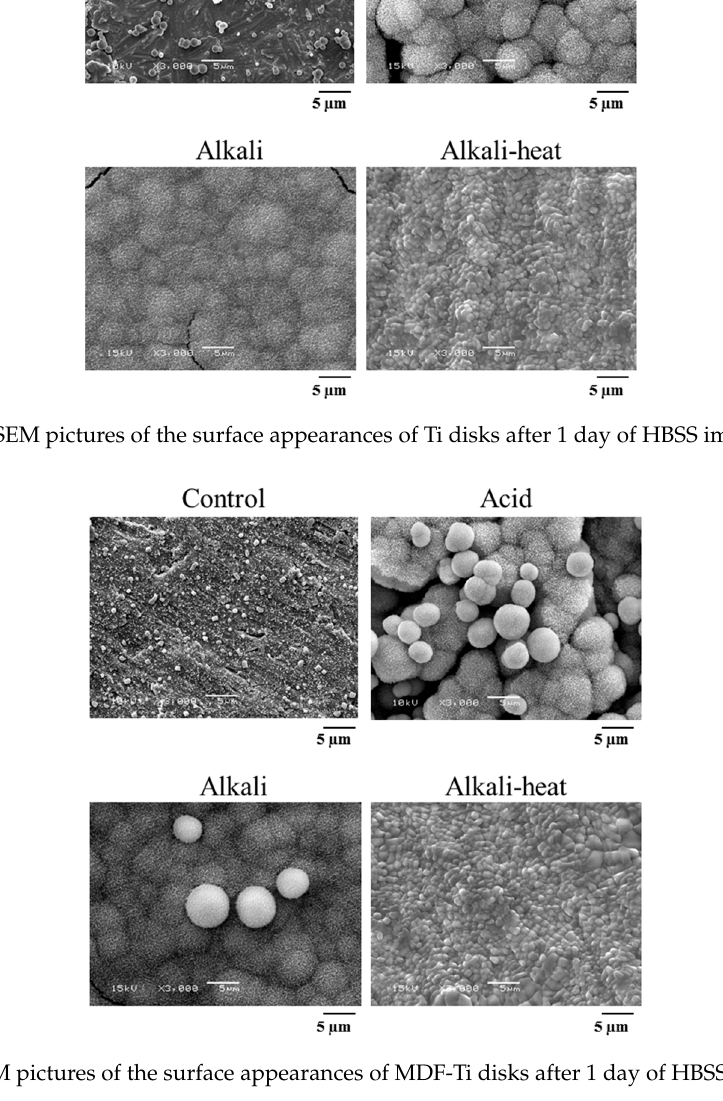
Figure 8. SEM pictures of the surface appearances of MDF-Ti disks after 1 day of HBSS immersion.